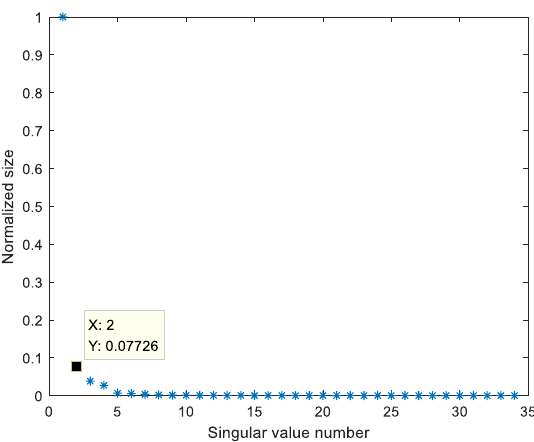
Figure 5. Singular value spectrum of radar echo.